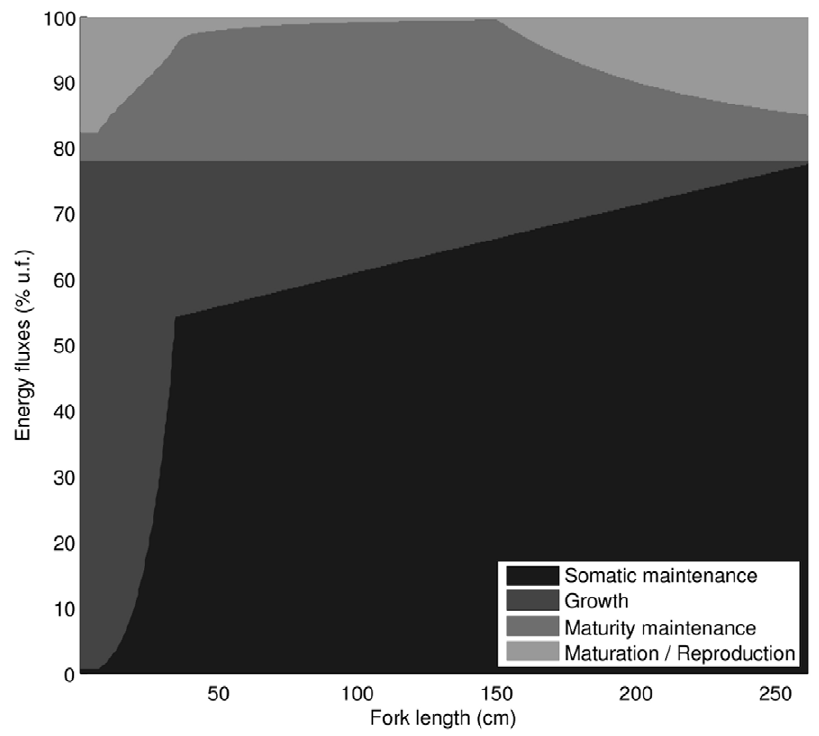
Figure 13. Energy fluxes relative to utilization flux as a function of fork length.